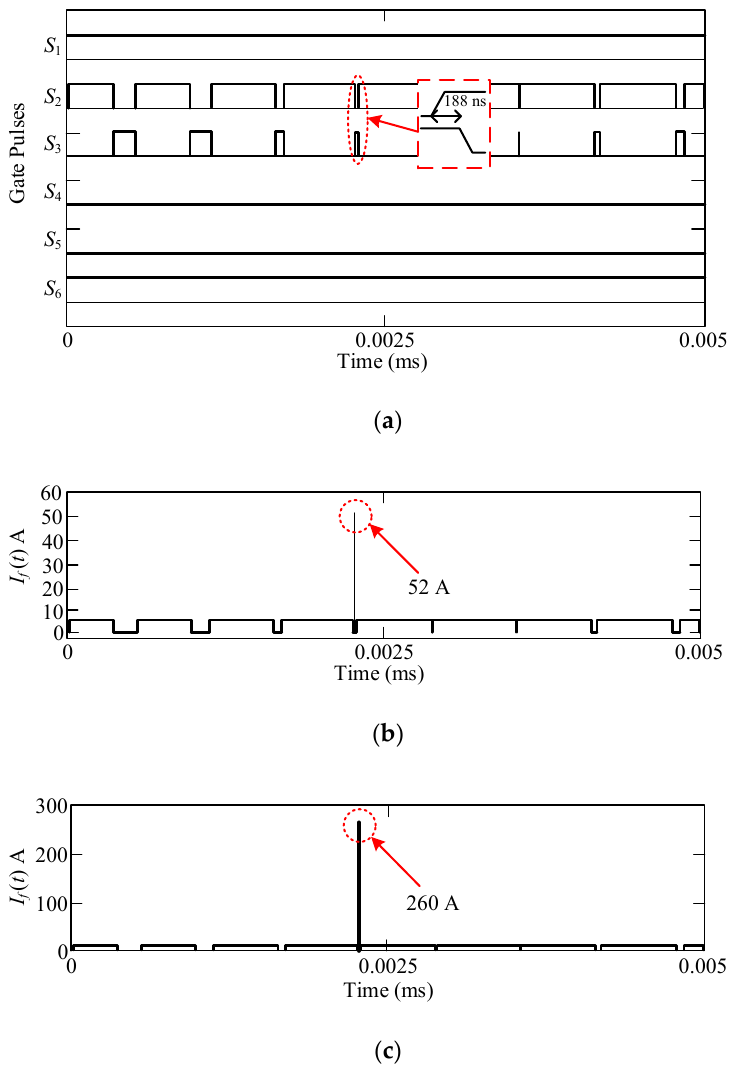
Figure 7. Shoot through fault current analysis: ( a ) gate pulses of S 2 and S 3 overlapping and causing shoot through fault, ( b ) hybrid ANPC, ( c ) conventional ANPC.